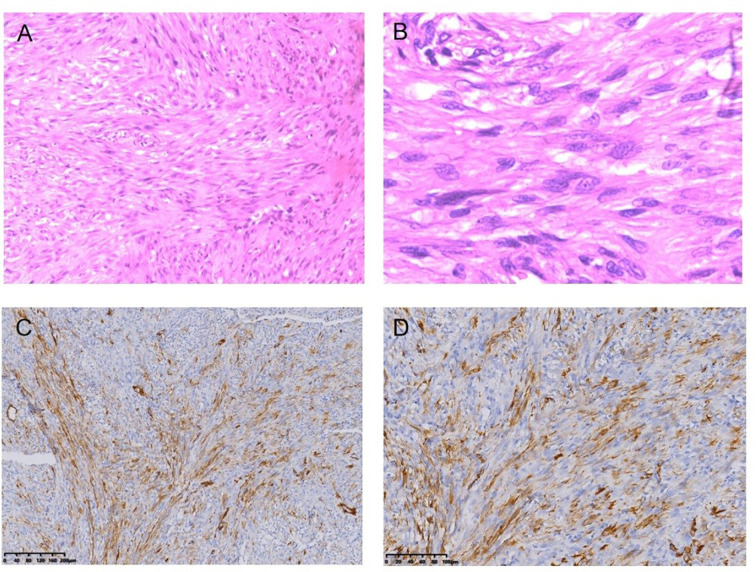
Fibrosarcoma following RT for NPC HE staining (*100) (A), HE staining (*400) (B), Immunohistochemical (IHC) staining: SMA + (*100) (C), SMA + (*200) (D).